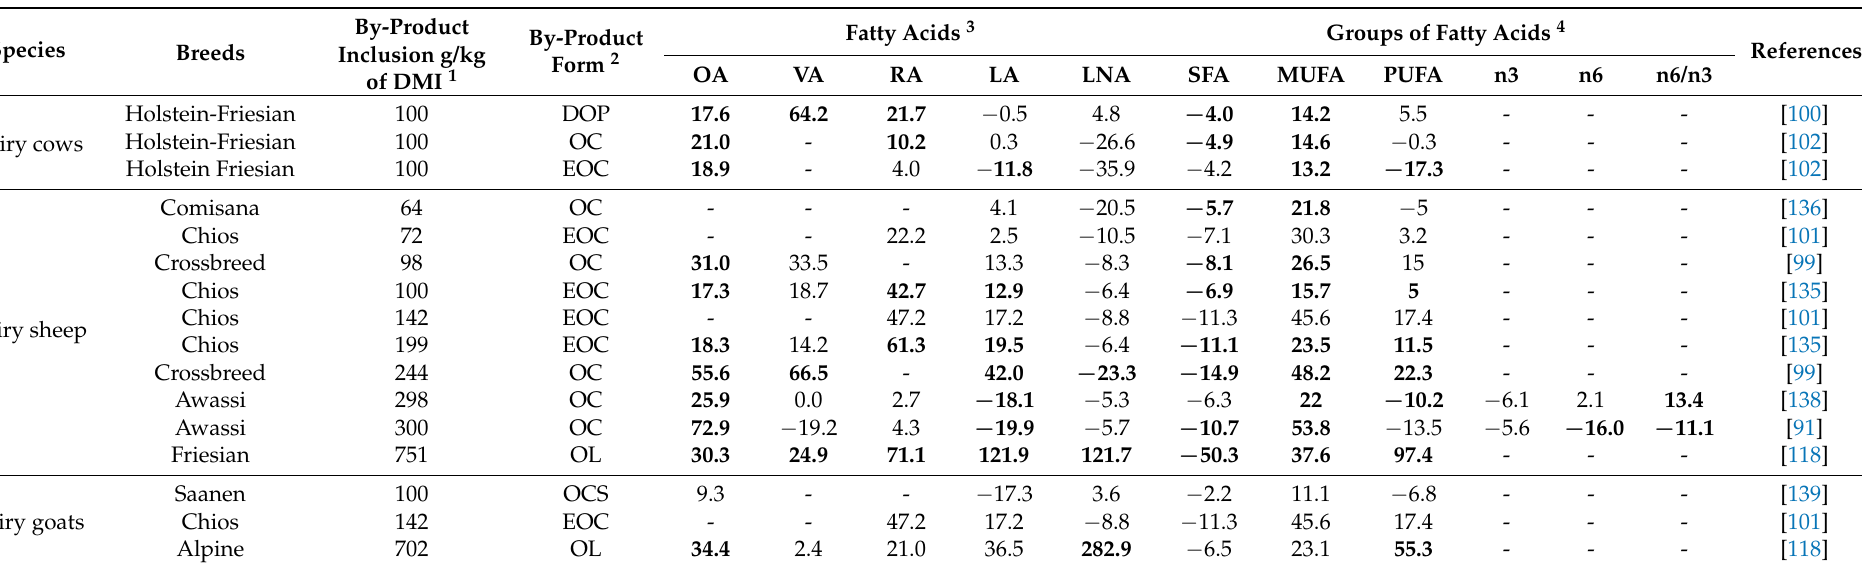
Table 7. Effect of olive by-products included in dairy ruminants’ diets on milk content of oleic acid (OA), vaccenic acid (VA), rumenic acid (RA), linoleic acid (LA), alpha-linolenic acid (LNA), saturated (SFA), monounsaturated (MUFA), and polyunsaturated (PUFA) fatty acids. Data are reported as the proportional difference between the treatment group, at the respective level of inclusion, and the control